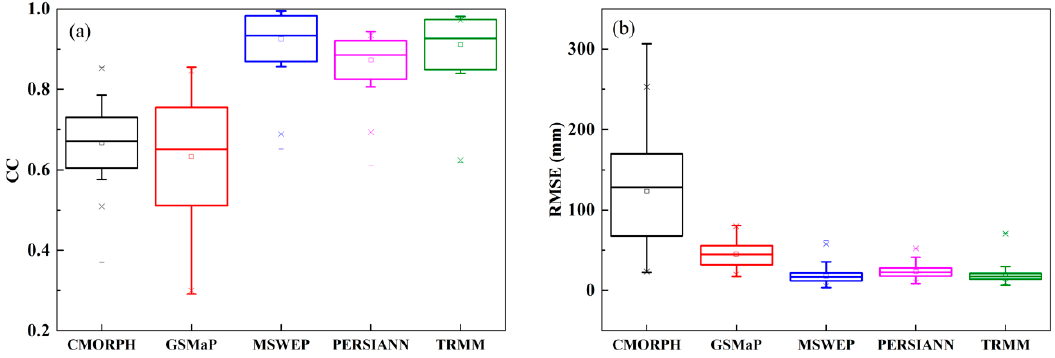
Figure 4. ( a ) correlation coefficient and ( b ) root mean square error of monthly precipitation between gridded and gauge datasets. CC is correlation coefficient, RMSE is root mean square error.